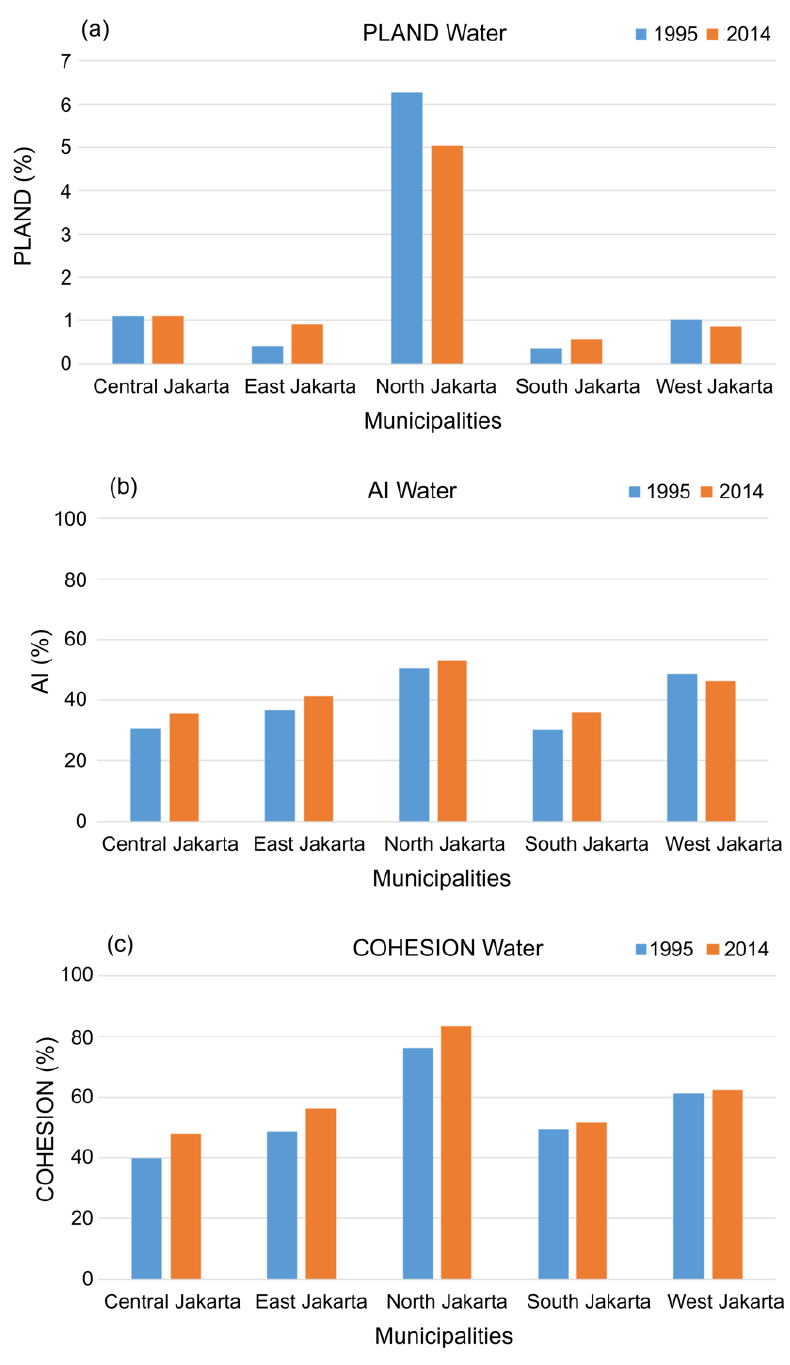
Figure 9. Landscape metrics of water. ( a ) Land proportion; ( b ) aggregation index; ( c ) cohesion.